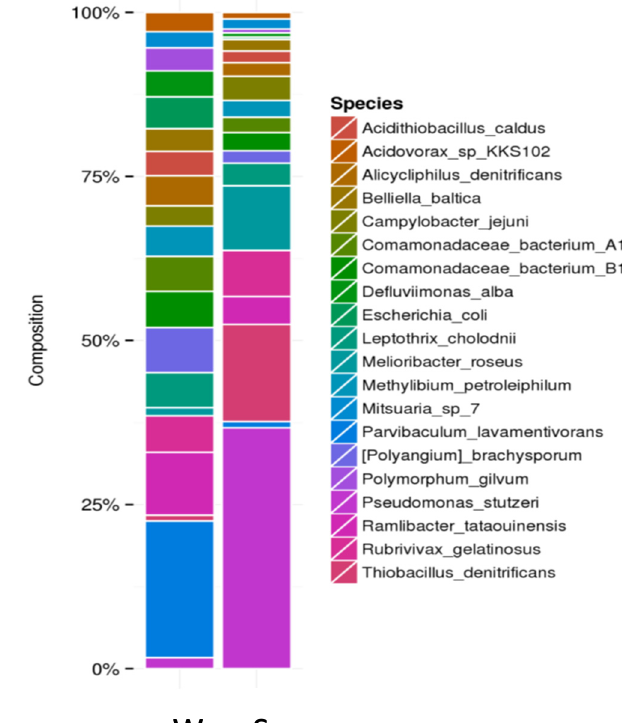
w s w s Figure 3. Genus- and species-level distributions in water (w) and sediment (s) samples from Karvachar geothermal spring. Table 4. Bacterial and archaeal phyla detected in culture-independent studies on Armenian geothermal spring microbiomes. Geothermal